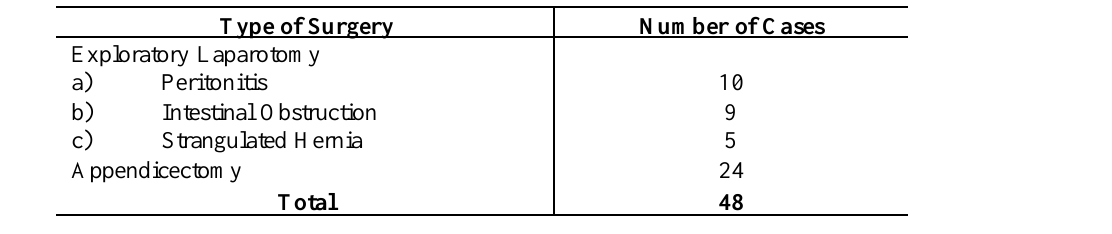
Table I : Emergency Major General surgery